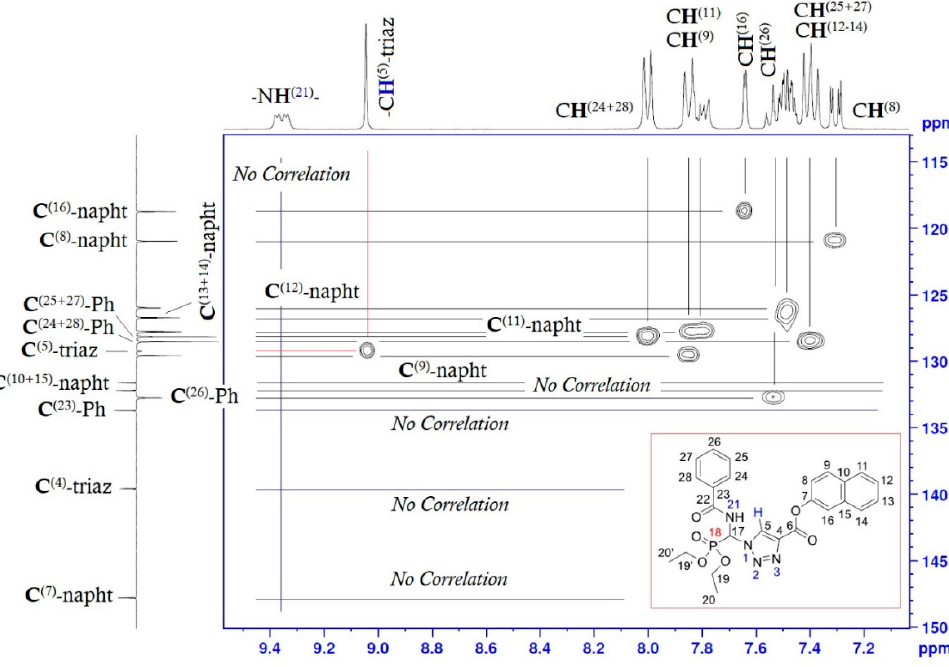
Figure 6. Two-dimensional HSQC spectrum of the cycloadduct ( 3 ) (Aliphatic part).